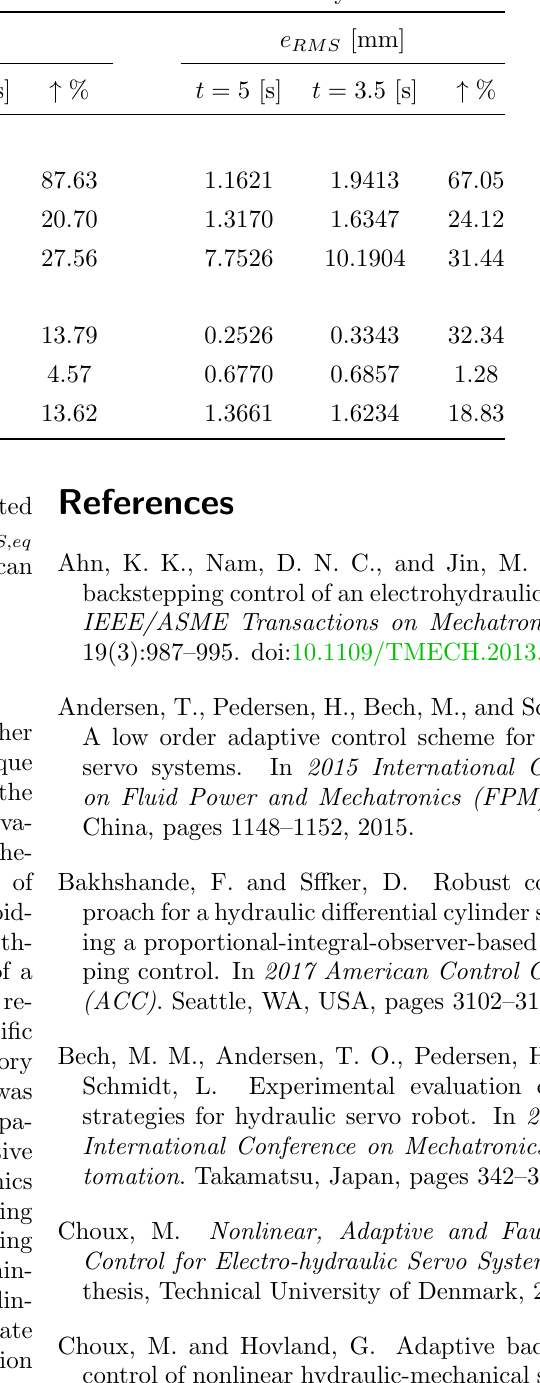
Table 1: Error indexes and percent increase for both servo